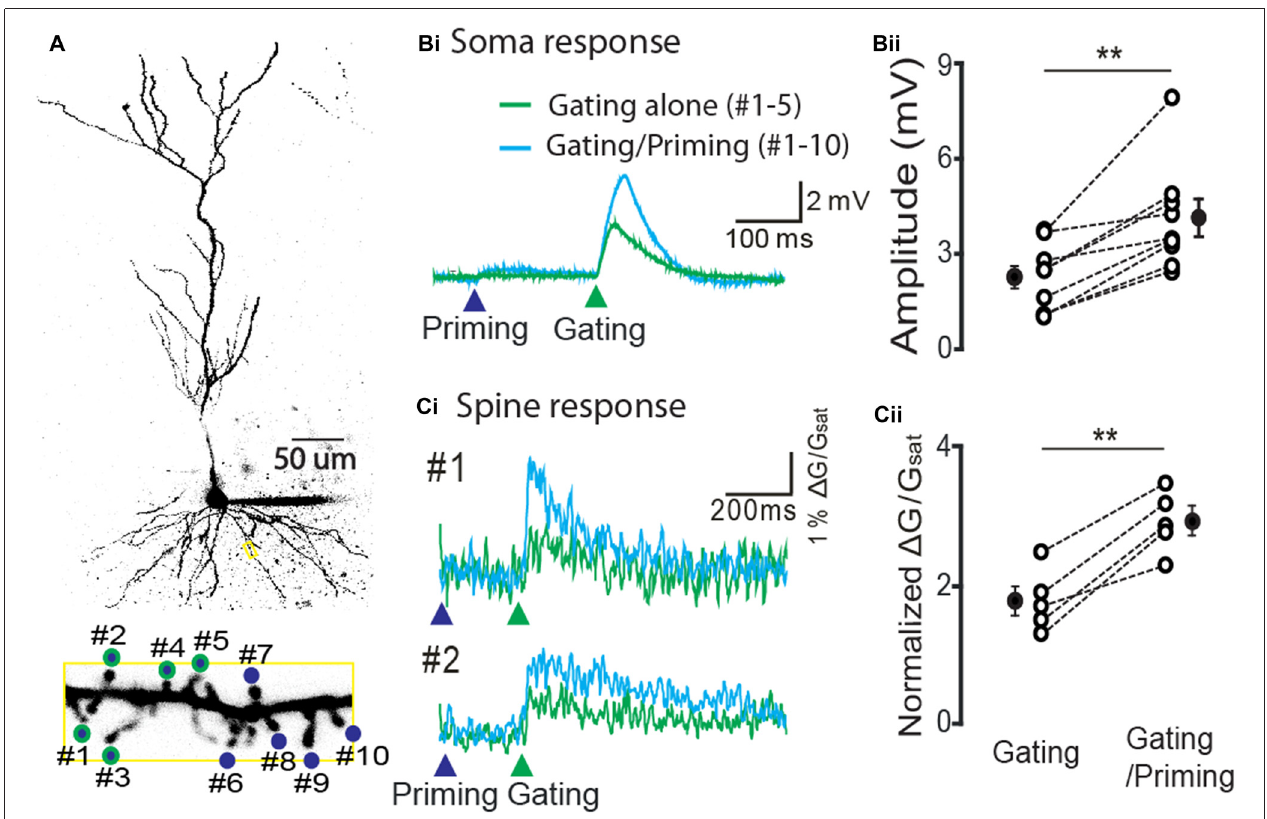
FIGURE 4 | Hippocampal STPP at a spine level. (A) Two photon image of a CA1 pyramidal neuron and its basal dendrite with priming (blue color)/gating glutamate uncaging spots (green outline) on the individual spines in a basal dendrite. (B,C) The representative responses to priming plus gating (cyan trace) and gating alone (green trace) glutamate uncaging were shown as photoactivated EPSPs. When the priming stimulus proceeded the gating stimulus, the facilitated read-out responses (cyan traces) were elicited in both the electrical recording at the cell body (Bi) and calcium transients on individual spines (Ci) . Population data in electrical recording on cell body ( Bii , n = 9 cells/4 animals) and calcium transients on the spines ( Cii , n = 5 cells/3 animals). Error bars represent SEM. ∗∗ p <